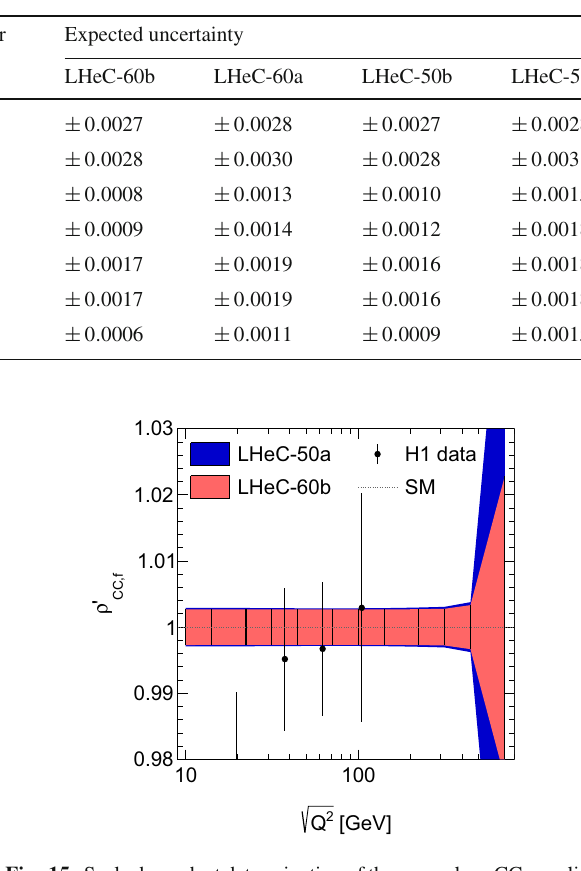
= ρ (cid:9) = ρ (cid:9) . For comparison, val- CC , eq CC , e ¯ q CC , f